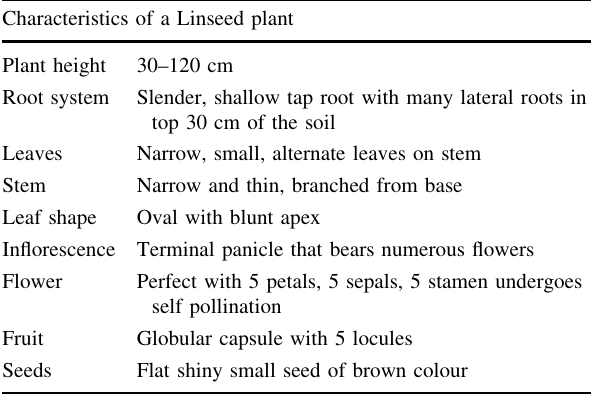
Table 2 Characteristics of the Linum usitassimum (Linseed) plant Characteristics of a Linseed plant